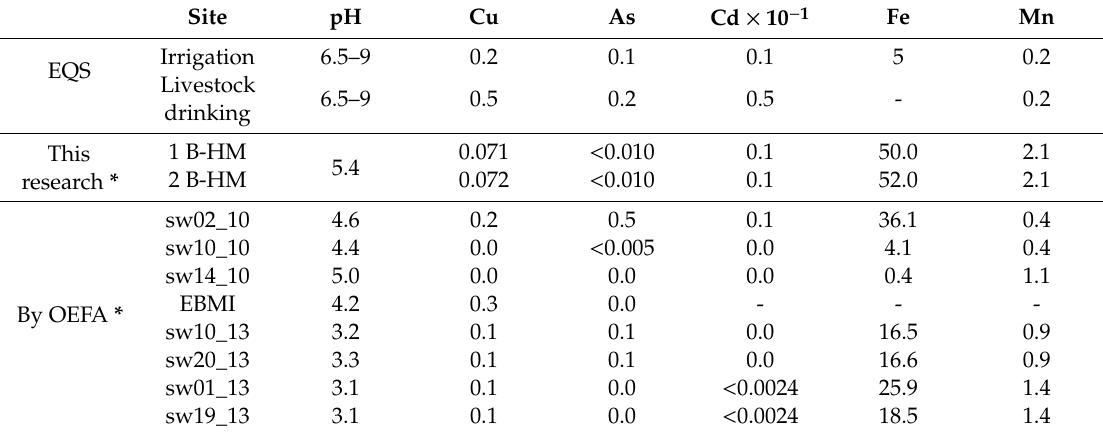
Table 6. Total metal concentrations (mg L − 1 ) in water samples exceeding EQS in the Aimaraes sub-basin.